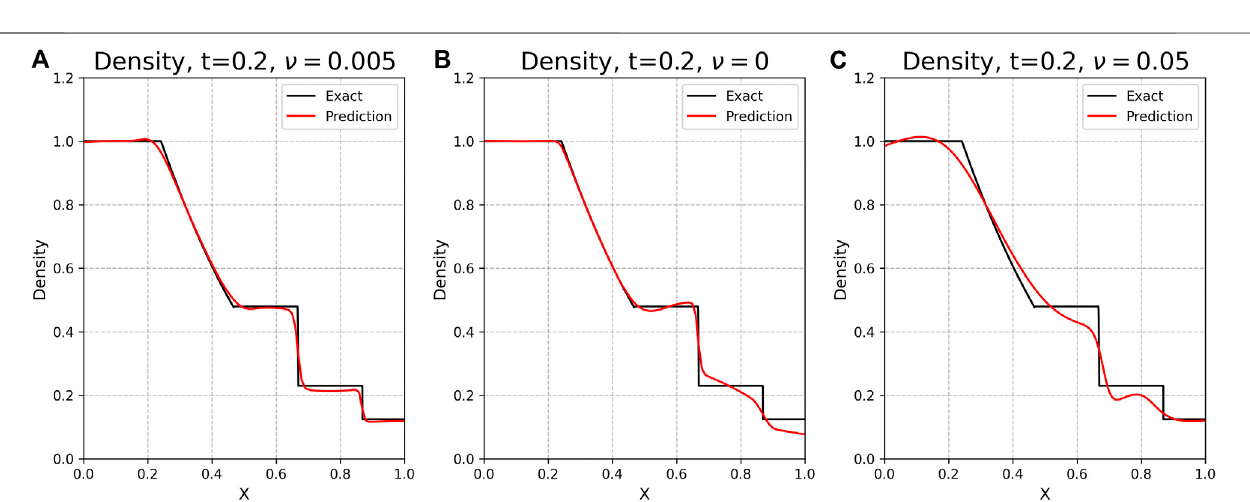
FIGURE4| Comparison ofexactvalueswithPINN-generated predictionsfor ρ at t (cid:1) 0.2,fordifferentvaluesoftheviscosity term. (A) :Thedefaultsetting ] (cid:1) 0.005. (B, C) : Same, for ] (cid:1) 0, 0.05. Adding a viscosity term helps the PINN generate a better fi t than without, though adding too much viscosity leads to very diffusive discontinuities and a poorer fi t. Without the viscosity term, the PINN struggles to resolve the shock discontinuities. All PINNs in this example were trained with the same architecture and learning schedule and for the same number of epochs, using the four-spacecraft trajectory data.